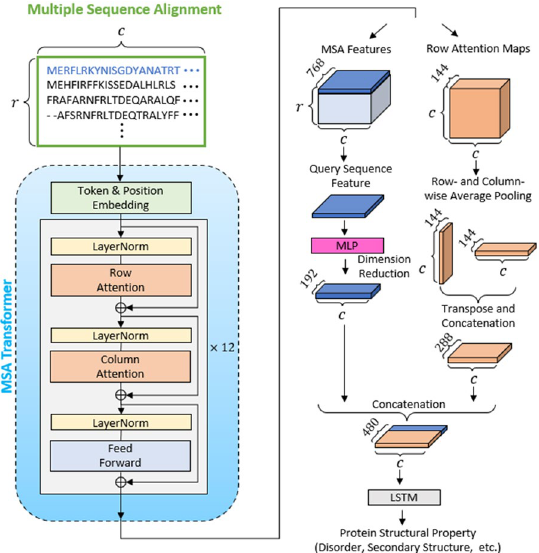
Figure 1. Architecture of the S-Pred method. The MSA Transformer extracts features and row attention maps from the input MSA of a query sequence. Next, through a series of transformations, the MSA features corresponding to the query sequence and the row attention maps are combined to 1D feature vectors. The 1D feature vectors are then input in an LSTM to predict protein structural properties including, SS8, ASA, and